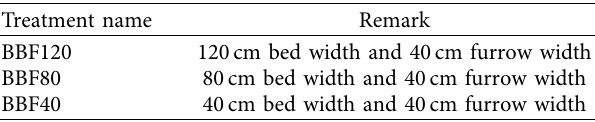
NB: use this table for further identification of treatments in all sections of the